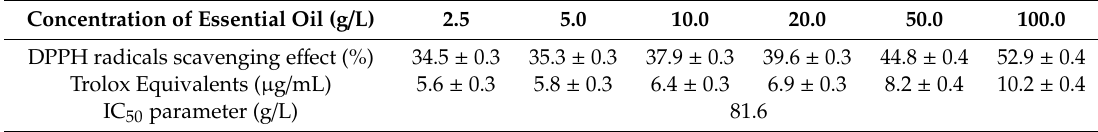
Table 5. Antioxidant activity of essential oil from sonicated celery